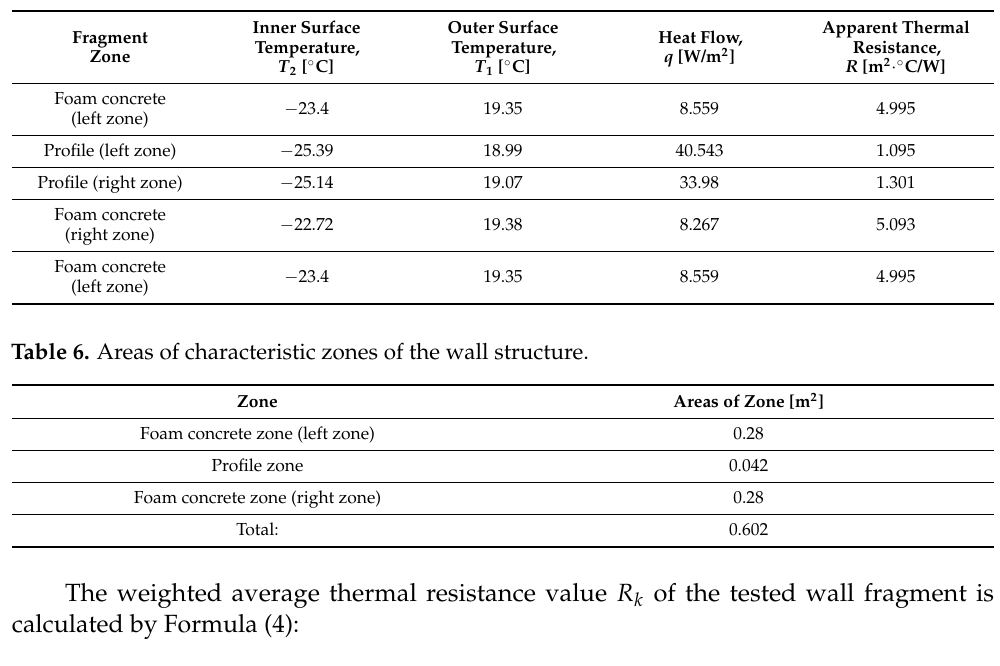
Table 5. Wall fragment with a vertical field joint.